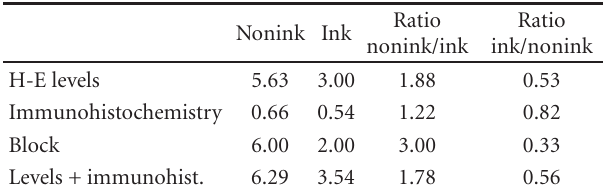
Table 3: Relation of the use of resources for each method and sample (mean